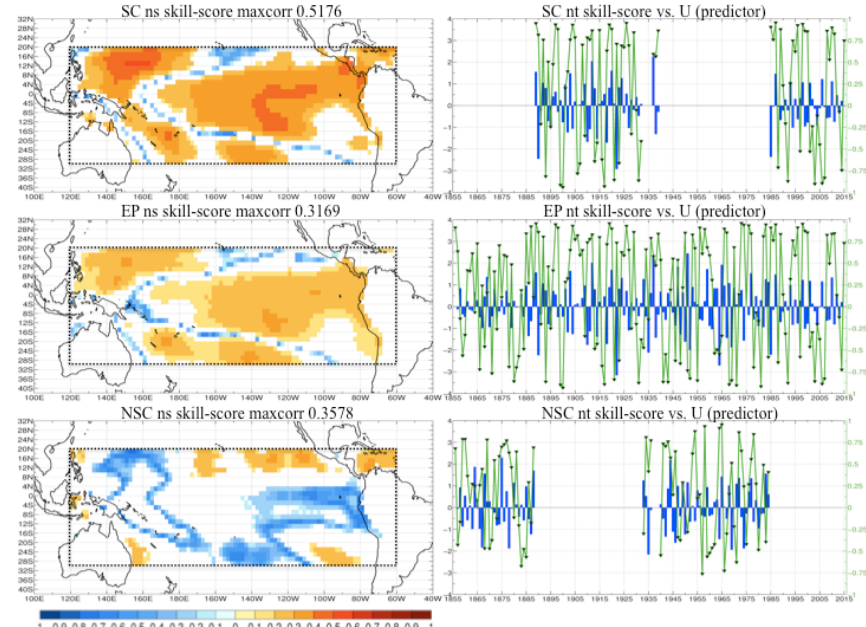
Figure 9. Skill-score validation using Pearson correlation coefficients between observations and hindcasts. Left column corresponds to the spatial validation for each point in space. Right column corresponds to validation time series (green line) between hindcasts and observations considering only the regions indicated by positive significant spatial correlation. Period SC (top panels), EP (middle panels), and NSC (bottom panels). Significant correlation values for time series are indicated by shaded triangles. Blue bars correspond to the expansion coefficient ( U ) of the SSTA (predictor). Significant values are plotted from a 90% statistical significance under a Monte Carlo